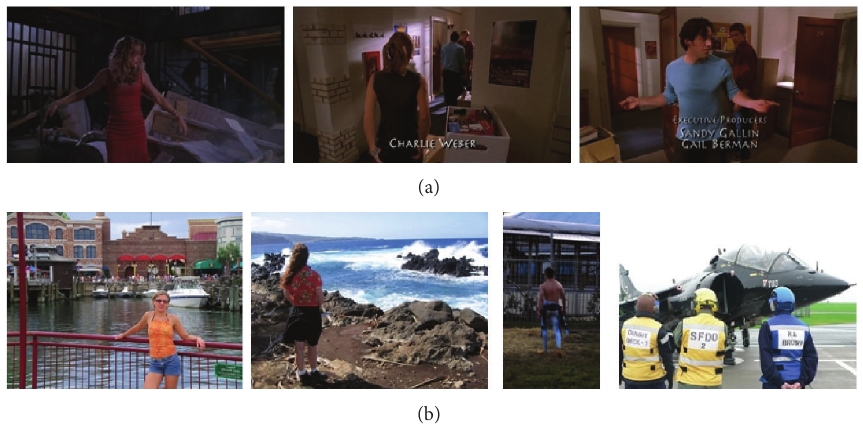
Figure 6: Some example images in Buffy (a) and PASCAL